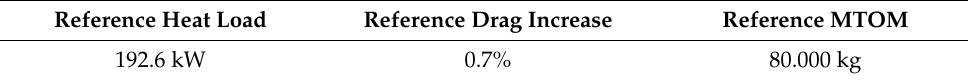
Table 6. Reference values for the thermal management system drag by